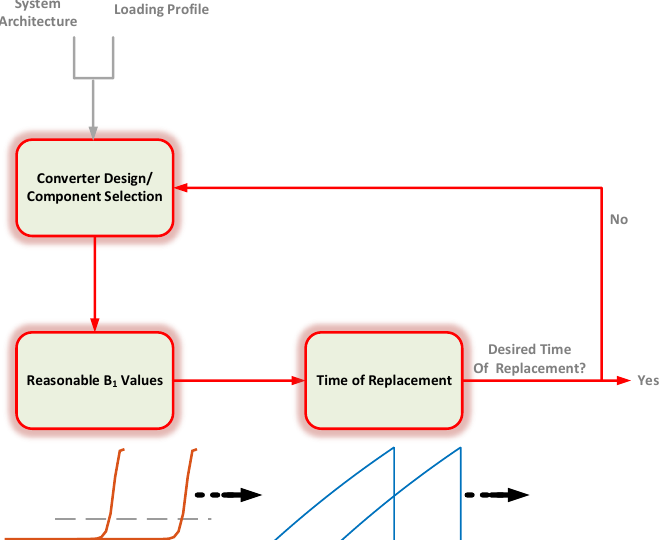
Figure 18. Lowering the frequency of converter replacements by incorporating design for reliability methods, where power electronic components are reinforced until desired B 1 lifetime is obtained, which will directly influence the replacement